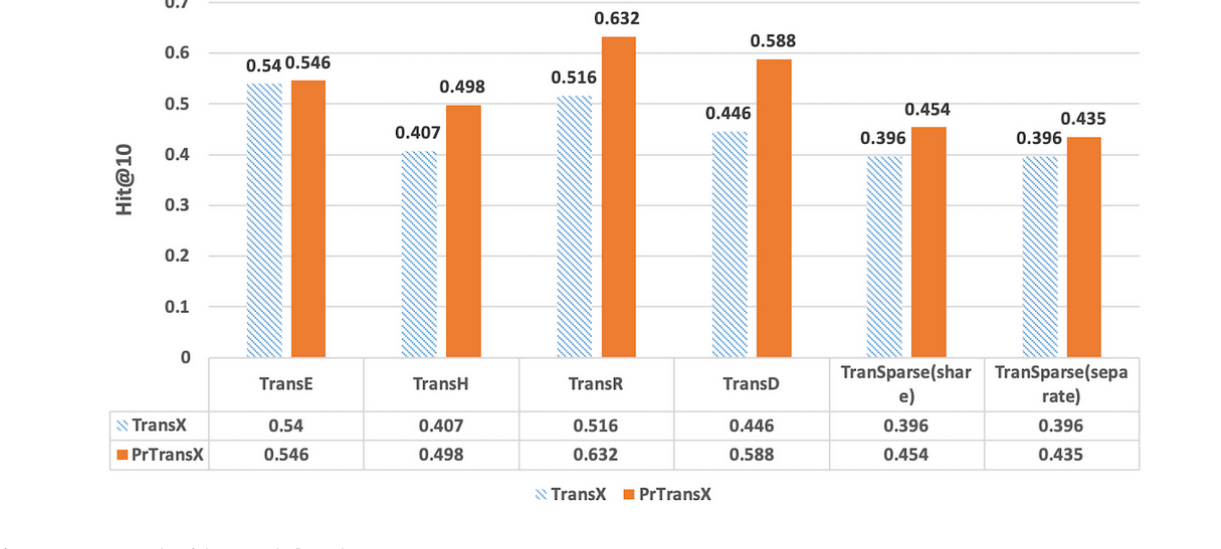
Figure 4. Mean rank of the tested